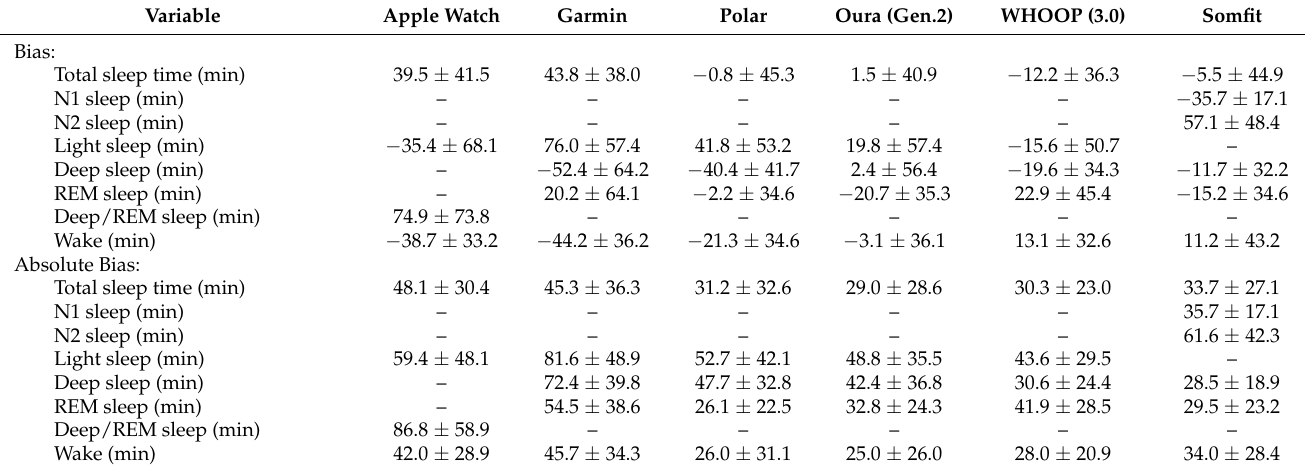
Table 4. Biases between PSG and each device for sleep metrics. Data are mean ±